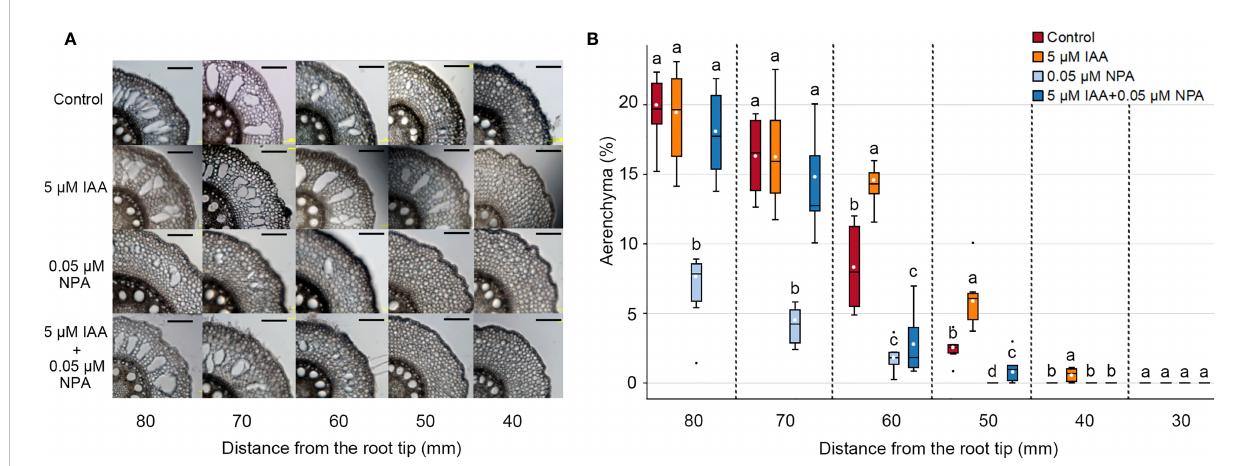
FIGURE 1 Aerenchyma formation in the third nodal roots of Z. nicaraguensis under aerated conditions with IAA and/or NPA treatments. (A) Cross-sections at 40, 50, 60, 70, and 80 mm from the tips of third nodal roots with or without 5 µM IAA and 0.05 µM NPA treatments. Scale bar = 200 m m. (B) Percentage of aerenchyma in root cross-sectional areas at 30, 40, 50, 60, 70, and 80 mm from the root tips. Boxplots show the median (horizontal lines), 25 th to 75 th percentiles (edge of the boxes), minimum to maximum (edge of the whiskers), and mean values (dots in the boxes) ( n = 6). Signi fi cant differences among the treatments are denoted with different lowercase letters ( p < 0.05, one-way ANOVA, followed by LSD test for multiple